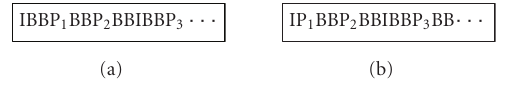
Figure 3: I-, B-, P-picture reorderings: (a) display order, (b) send bu ff er output